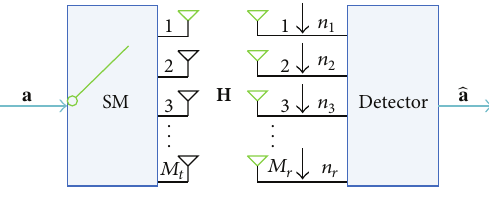
Figure 1: The model of spatial